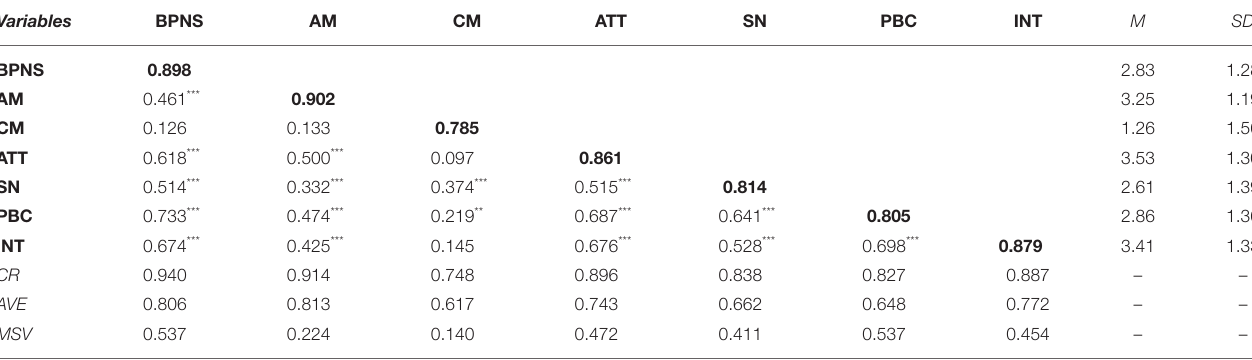
TABLE 2 | Means, standard deviations, bivariate correlations, and model validity measures. Variables